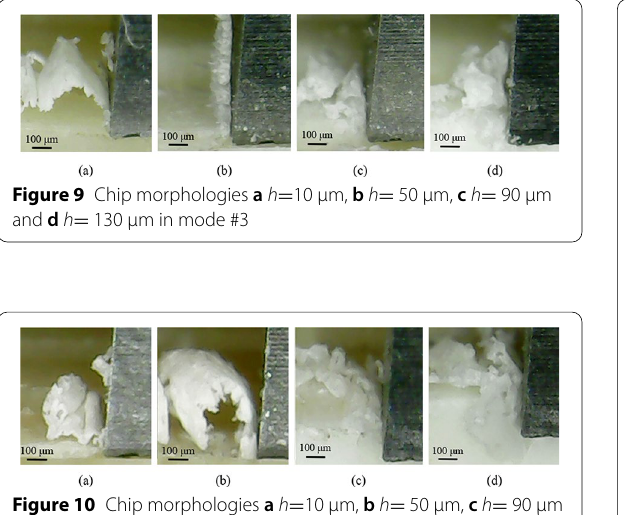
Figure 11 Cutting forces with the depth of cut of 10 μm: a Mode #1, b Mode #2, c Mode #3, and d Mode #4